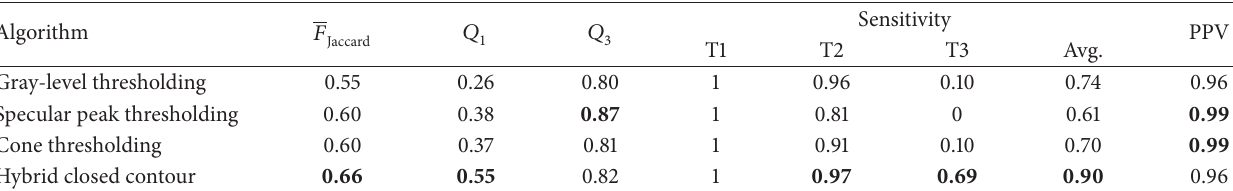
Table 1: The hybrid closed contour algorithm achieves the best results compared to thresholding techniques in terms of the Jaccard index and sensitivity. Note the high value for 𝑄 1 and the sensitivity; this increase is caused by the reflections of Type 3 (T3) which are missed by the other